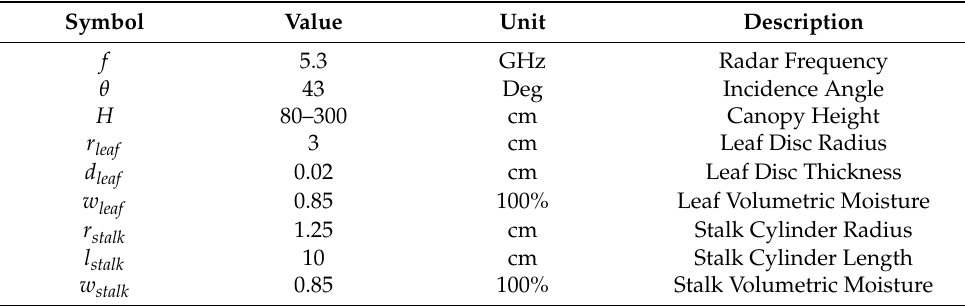
Table 1. Input parameters of canopy A.